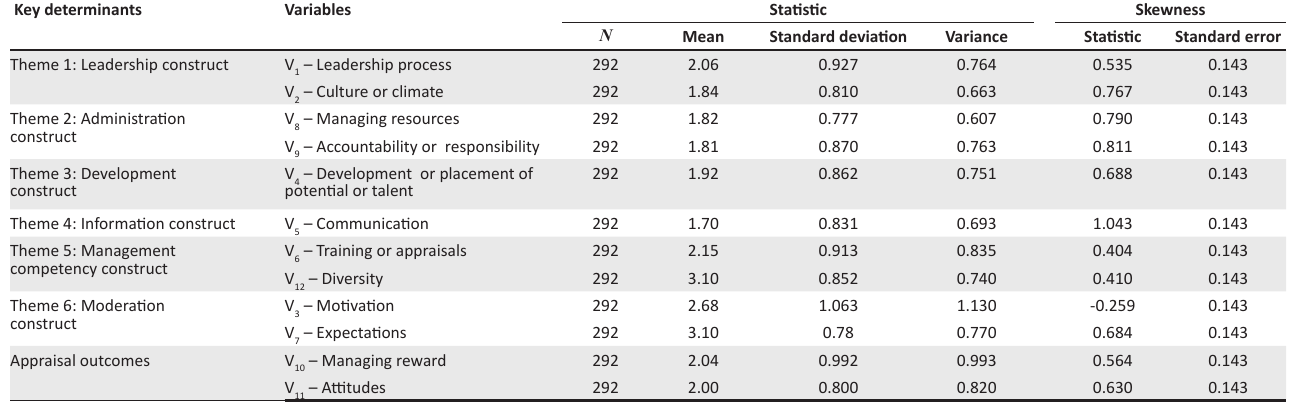
TABLE 6: Descriptive statistics of key determinants of the EPMDS.